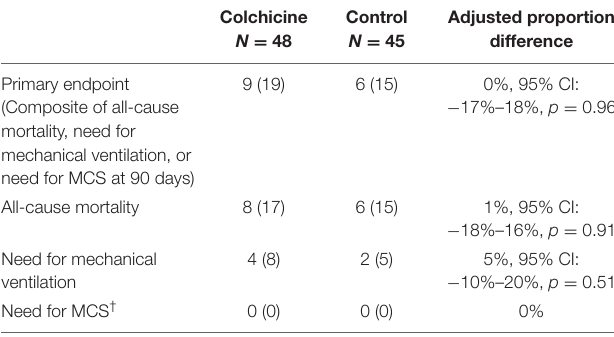
Colchicine Control Adjusted proportion N = 48 N = 45